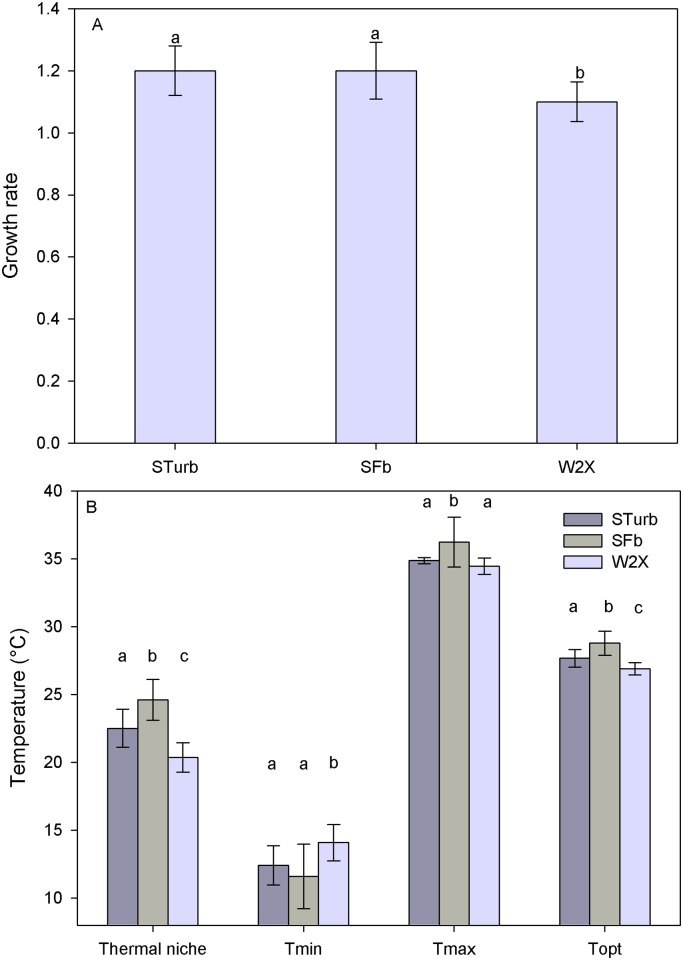
Comparison between the new STurb and SFb strains and the initial W2X strain.A) Growth rate. B) Cardinal temperatures and thermal niche. Values are expressed as the mean ± standard deviation determined by a jackknife analysis. Groups marked with the same letter (a, b or c) are not statistically different (1% error, Student test). Different letters indicate groups statistically different.